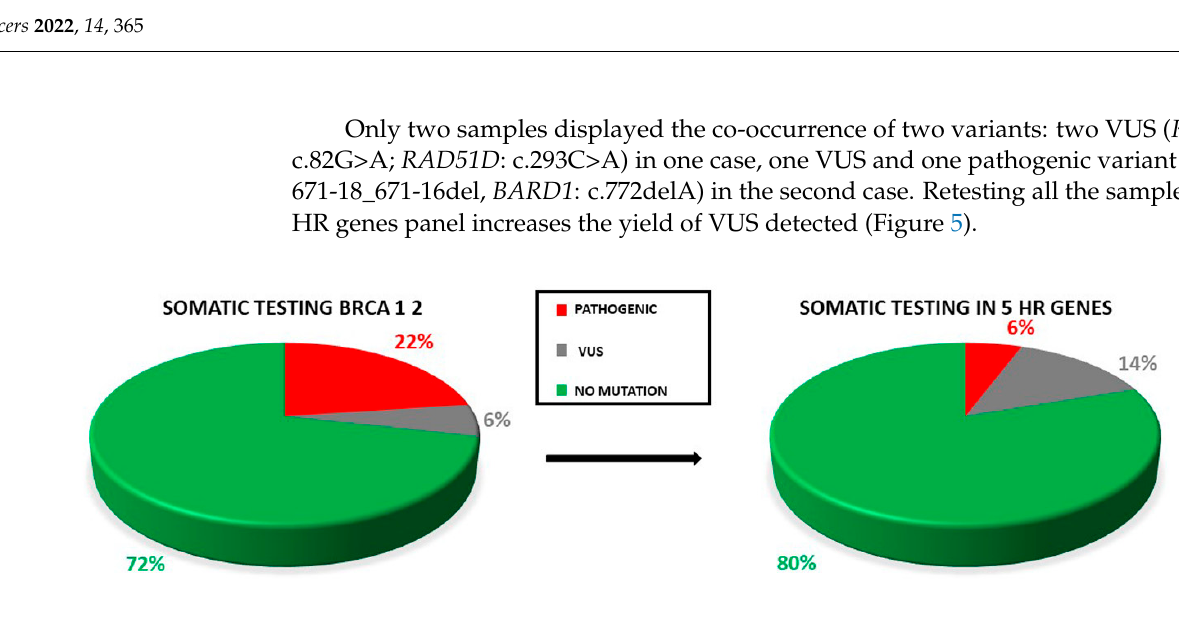
Figure 5. Proportion of pathogenic variants and VUS in testing only BRCA1/2 genes and retesting all the OC samples for the five HR genes. The rate of VUS detection is